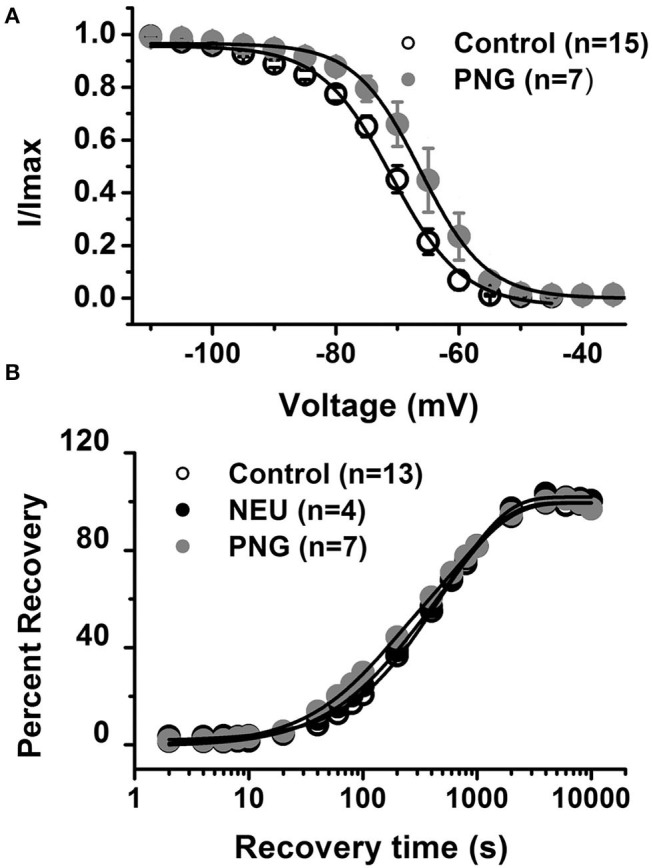
De-glycosylation with PNGase-F (PNG) causes depolarizing shift in voltage-dependent inactivation of CaV3.2 currents similar to NEU, but neither PNG nor NEU influence time course of recovery from inactivation. (A) When compared to untreated control cells (open symbols) treatment of HEK293 cells with PNG (gray symbols) induced significant shift of V50 in steady-state inactivation curves from −71.6 ± 1.2 mV (n = 15) to −66.0 ± 2.2 mV (n = 7, p < 0.05). (B) Average graph from the experiments in 13 untreated (control) cells (open symbols), 4 cells treated with NEU (black symbols) and 7 cells treated with PNG (gray symbols) is shown on this panel. When compared with control conditions treatment with NEU or PNG minimally affected time course of recovery from inactivation of recombinant CaV3.2 currents. We used 10 mM Ba2+ as a charge carrier in these experiments.